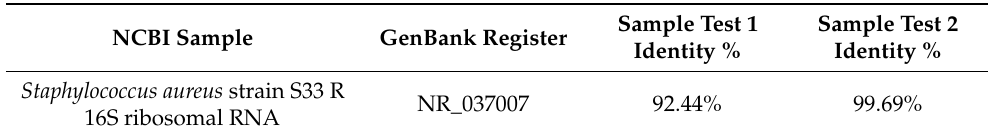
Table 2. Identity of Staphylococcus aureus deposited on database, comparing with the Staphylococcus aureus of this